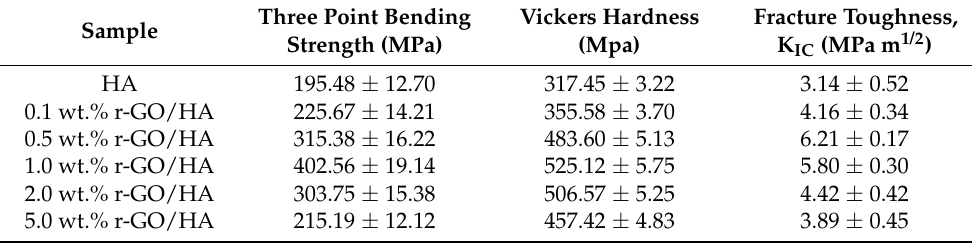
Table 2. The mechanical properties of HA and r-GO/HA NCPs with different concentrations of r-GO. Three Point Sample